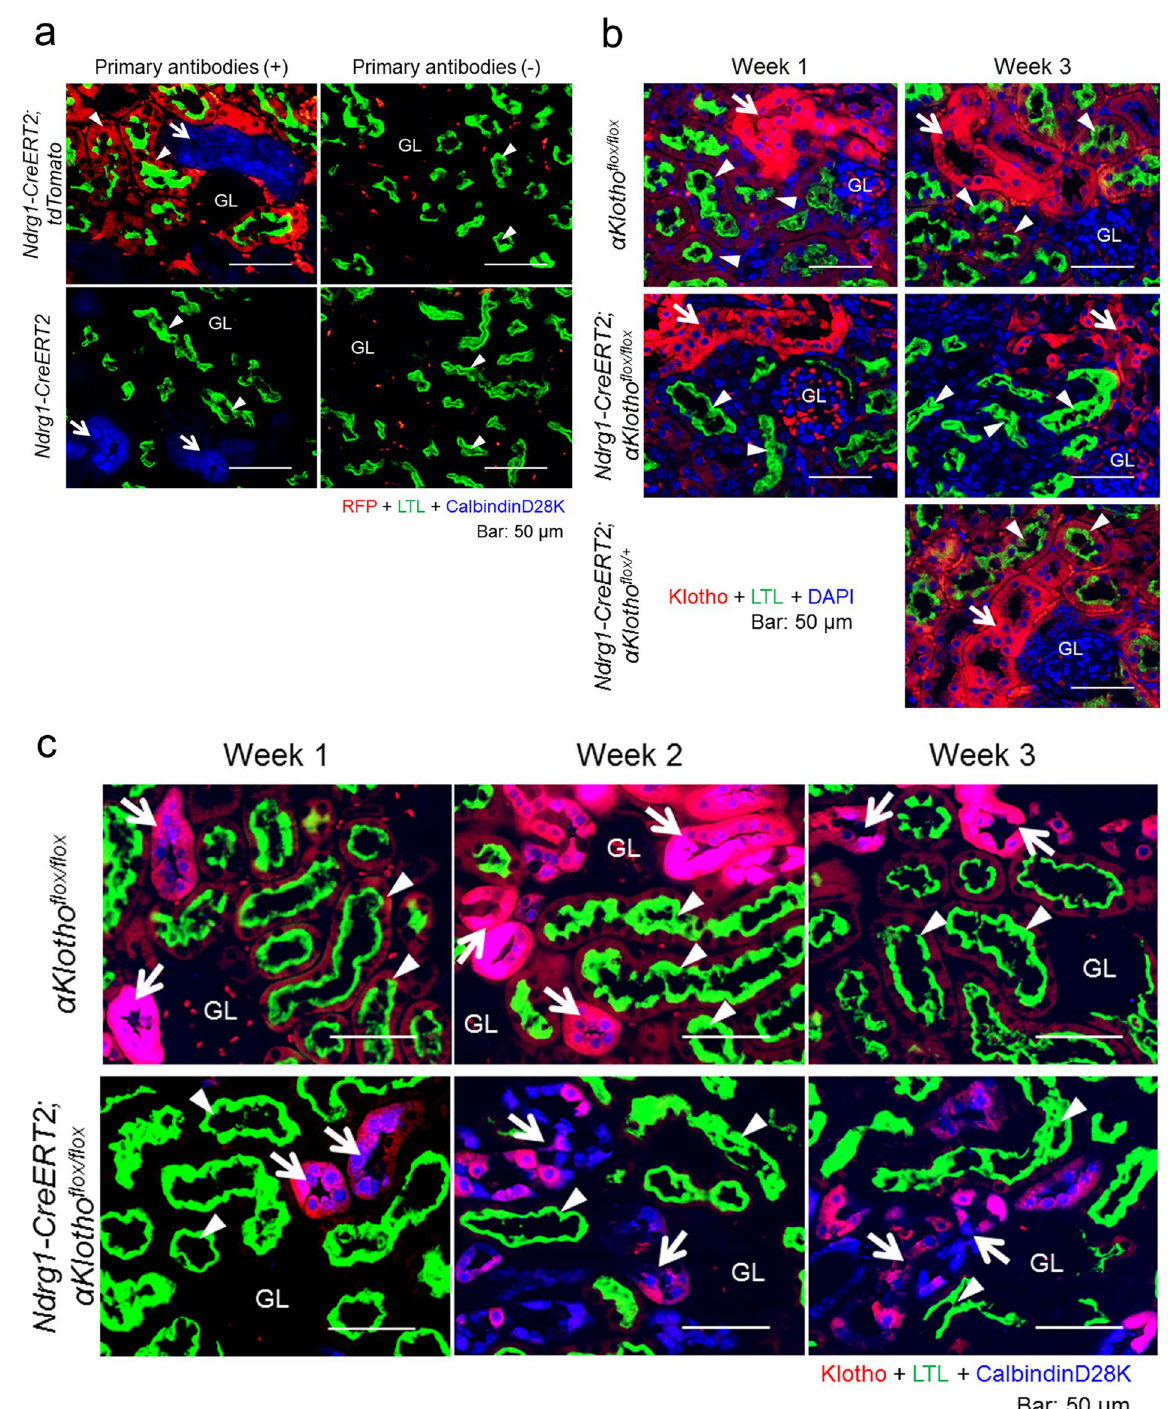
Figure 1. Proximal tubule-specific expression of Ndrg1-CreERT2 and its recombination efficiency in Ndrg1-CreERT2; α Klotho flox / flox mice. ( a ) Proximal tubule-specific expression of Cre in B6.Cg-Gt(ROSA) 26Sor tm9(CAG-tdTomato)Hze / J ( tdTomato ) mice mated with Ndrg1-CreERT2 mice. Tamoxifen (3 mg/20 g body weight/ day) was injected intraperitoneally for 5 consecutive days at the age of 5–8 weeks, and the mice were sacrificed 3 weeks later. Left panels: Kidney sections were co-immunostained for red fluorescent protein (RFP; red) and calbindinD28K (a marker for distal convoluted tubules shown in blue, arrows) with affinity marking by FITC-conjugated lotus tetragonolobus lectin (LTL, green) of the brush border membrane of proximal tubules (arrowheads). Right panels: The same experiments without any primary antibody (anti-RFP or anti- calbindinD28K antibody). Cre expression shown by positive RFP staining was specific for proximal tubules. GL: glomerulus. Scale bars: 50 μ m. ( b ) Renal α Klotho expression at 1 and 3 weeks after tamoxifen treatment in α Klotho flox / flox , Ndrg1-CreERT2; α Klotho flox / flox , and Ndrg1-CreERT2; α Klotho flox / + mice. Tamoxifen was injected to induce Cre as described above. The period after tamoxifen treatment was counted from the date